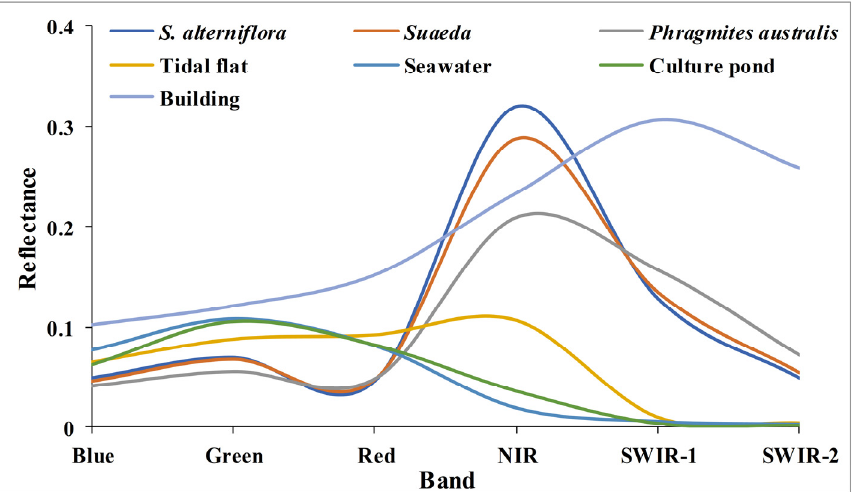
Figure 3. Spectral curves of the seven typical classes in the study area (from the Landsat 8 OLI image acquired on 16 August 2020).